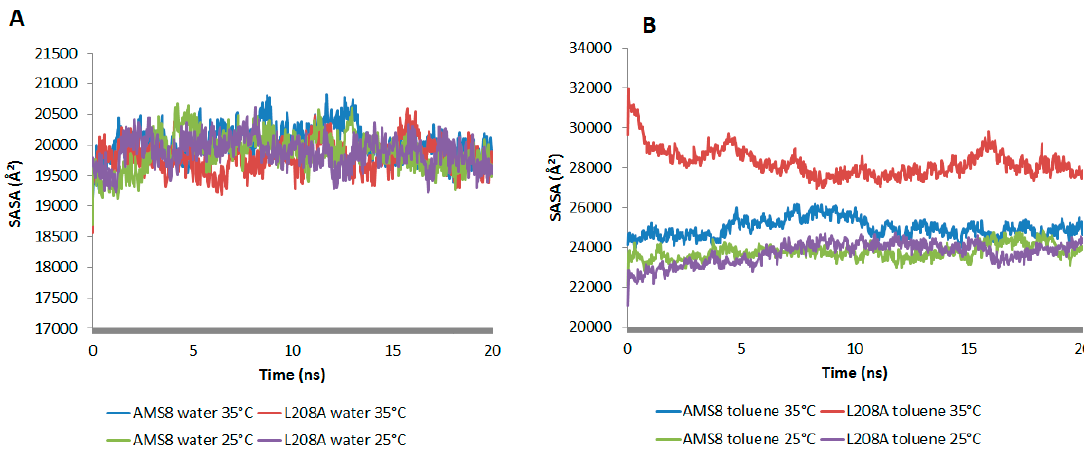
Figure 2. Solvent accessible surface area (SASA) analysis of WT AMS8 and mutant L208A lipases in water ( A ) and toluene ( B ) at 25 °C and 35 °C respectively. Larger SASA indicates highly exposed amino acids to organic solvent.